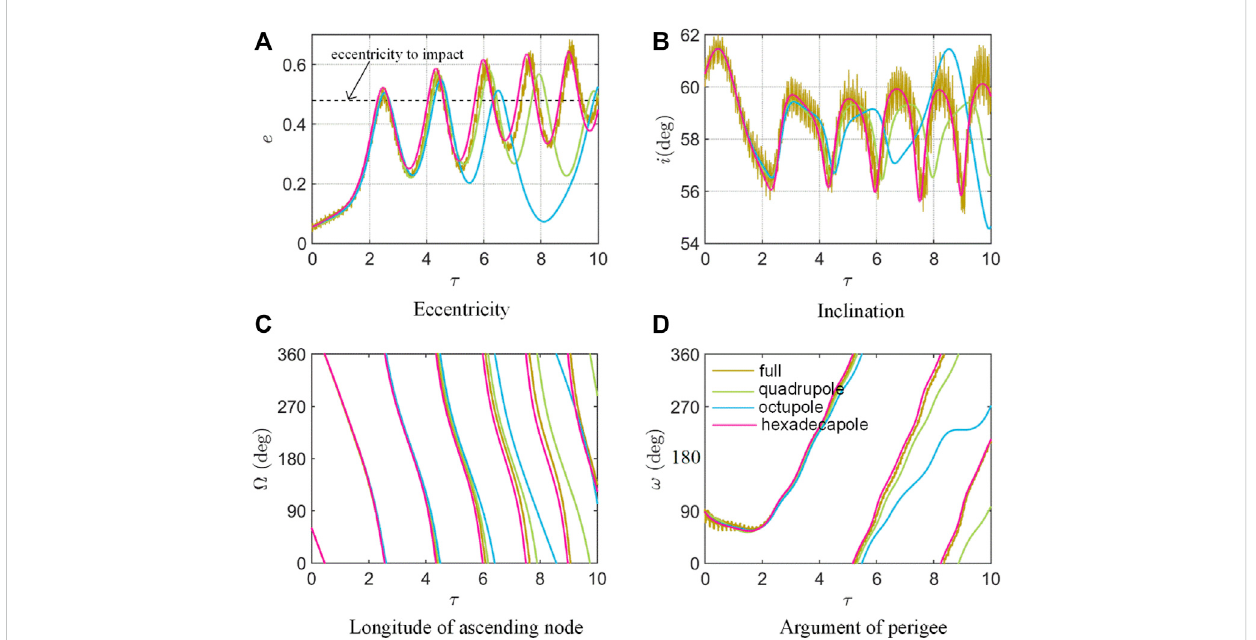
FIGURE 4 Long-term orbitalevolutionfor a (cid:2) 5 . 3km over 10scaledtime, obtainedbymodelsofdifferentapproximationlevels. Thepanels (A – D) arethetemporal evolutionoftheeccentricity, inclination, longitudeof ascending node,andargumentofperigee, respectively.Thefullmodelisgivenby Eq. 5with R PB givenin Eq. 56. The other three double-averaged models are given in Eq. 58 (by retaining their corresponding order). The curves of different models are marked by colors(thelegendisonlygiveninoneoftheplotsforsimplicity).Theinitialconditionsaresetas e 0 (cid:2) 0 . 05; i 0 (cid:2) Ω 0 (cid:2) 60 ° ; ω 0 (cid:2) 90 ° ; Ω 0 (cid:2) 60 ° ,; f 0 (cid:2) 0 ° (the initialtrueanomaly).Thesecondary ’ sorbithas a B (cid:2) 31km, e B (cid:2) 0 . 2 , i B (cid:2) 10 ° ,and Ω B (cid:2) Ω B (cid:2) f B (cid:2) 0.Theprecessionofthesecondary ’ sorbitisgovernedbyEqs. 51 and 52. The dashed line in the eccentricity fi gure denotes the critical eccentricity that will cause impact on the surface of the primary.